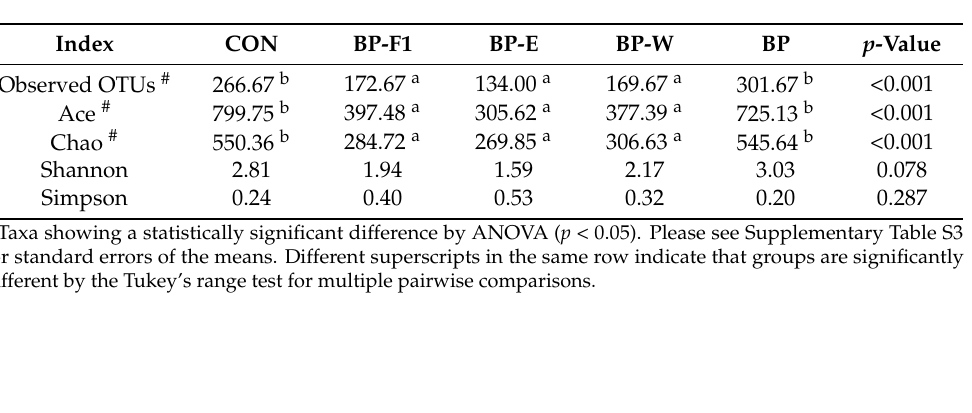
Table 5. Observed OTUs and alpha-diversity indices in five dietary treatment groups. Values are shown as